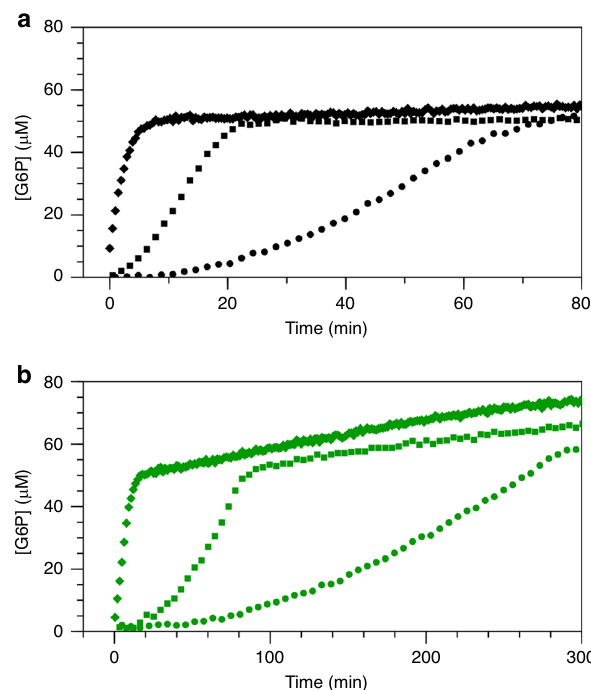
Fig. 5 Kinetic pro fi les of β PGM activity. a , b Reaction kinetics for the conversion of β G1P to G6P catalysed by β PGM WT and β PGM P146A . The rate of G6P production was measured indirectly using a glucose 6-phosphate dehydrogenase coupled assay, in which G6P is oxidised and concomitant NAD + reduction is monitored by the increase in absorbance at 340 nm. Reaction catalysed by either a β PGM WT or b β PGM P146A in standard kinetic buffer using either F16BP (circles), AcP (squares) or β G16BP (diamonds) as a phosphorylating agent. For clarity, between 100 and 8% of the data points are included in the kinetic pro fi les. Following β G1P substrate depletion, the kinetic pro fi les show an apparent increase in G6P concentration, which results from: (1) the concentration of the reaction ingredients through evaporation from the assay plate wells and (2) for the reactions recorded using β G16BP, the enzyme-dependent conversion of remaining β G16BP to G6P via β PGM P , occurring at a rate proportional to the amount of the position of the missing ε -amino group of K145 and its β PGM fi ed by a water molecule. WT hydrogen bonding are satis